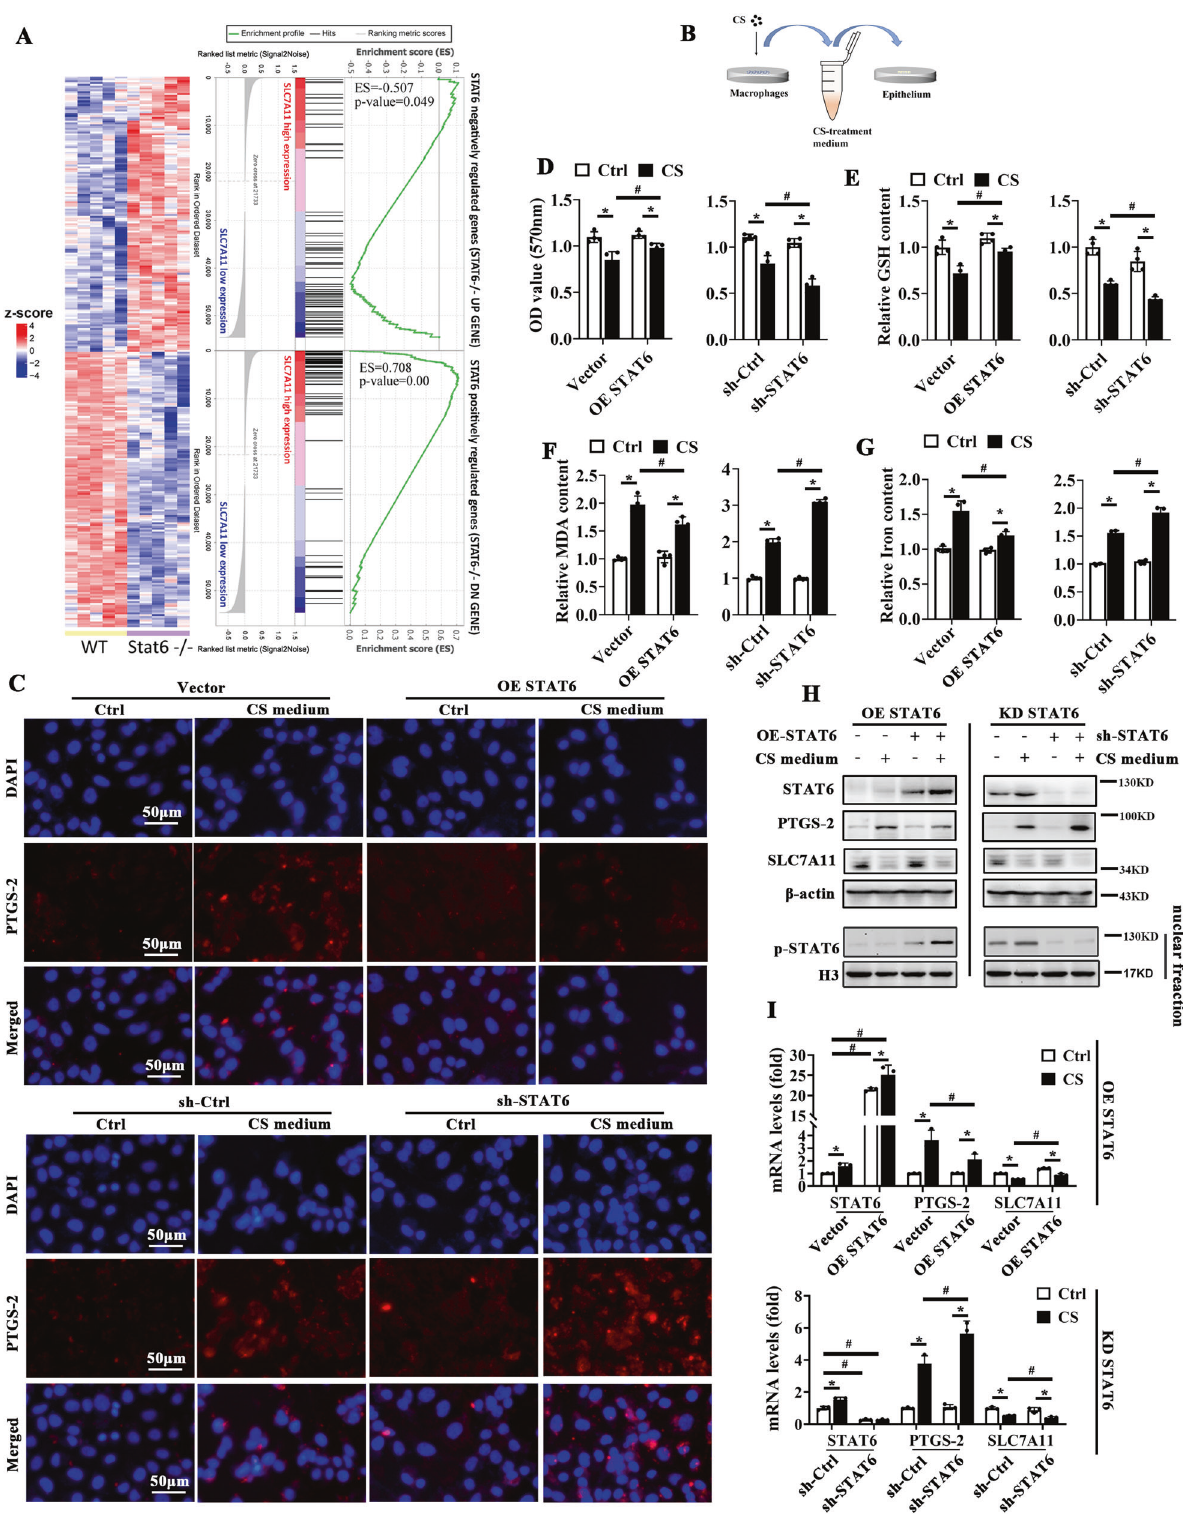
Fig. 3 STAT6 suppresses ferroptosis and positively regulates SLC7A11. A Left panel, heat map showed genes negatively or positively regulated by STAT6. Right panel, GSEA plot showed enrichment of “ STAT6 negatively regulated genes ” in SLC7A11 low expression group and “ STAT6 positively regulated genes ” in SLC7A11 high expression group. B The co-cultured system of macrophages and epithelium. HBE cells were transfected with sh-Ctrl or plasmid for STAT6 inhibition or overexpression and treated with CS-medium for 24 h. C Immuno fl uorescence staining of PTGS-2 in cells with indicated treatment. DAPI was used for nucleus staining. The cell viability D , GSH E , MDA ( F ) and Iron G content in cells were measured ( n = 4). The protein ( H ) and mRNA ( I ) levels of STAT6, PTGS-2 and SLC7A11 were measured by immunoblot analyses and qRT-PCR assay ( n = 3). The data were presented as means ± SD (* p < 0.05, Ctrl vs . CS; # p < 0.05, Vector/sh-Ctrl vs . OE-STAT6/sh-STAT6).